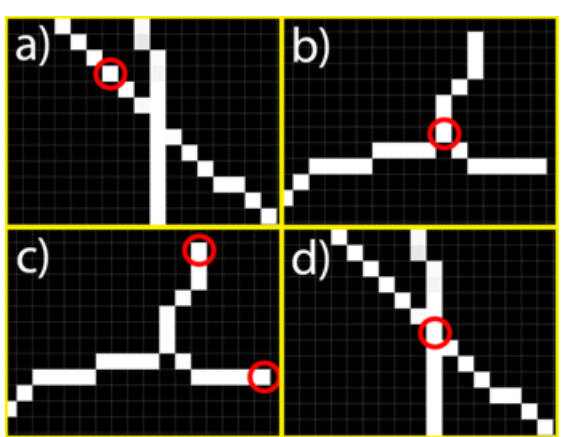
Figure 6. Four kind of points detected when analyzing the vessels’ skeleton. ( a ) normal; ( b ) branch; ( c ) final; ( d ) cross.